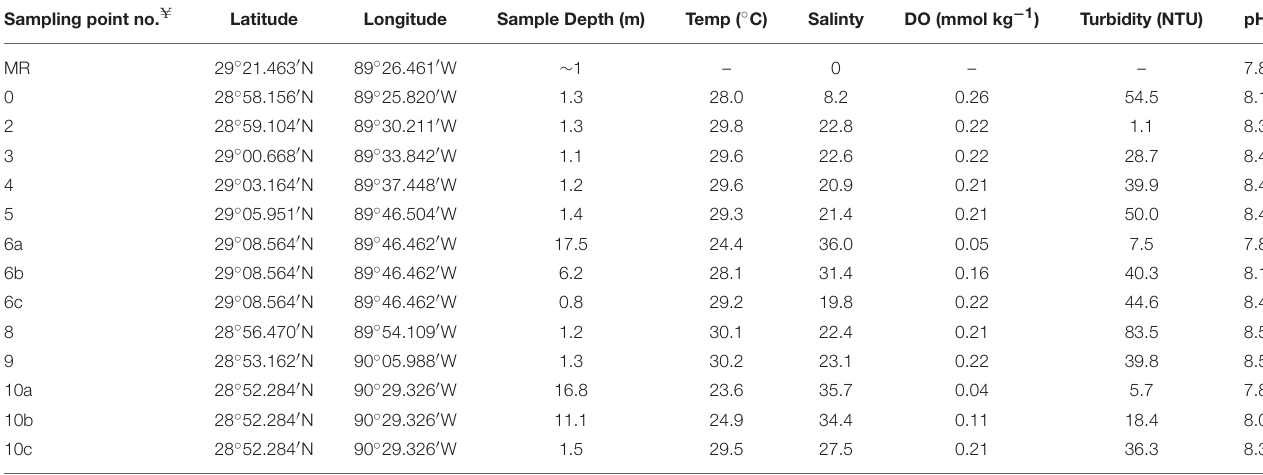
TABLE 1 | Field parameters characterizing the Mississippi River and estuary water samples, with individual sampling location and collection depth. Sampling point no. U